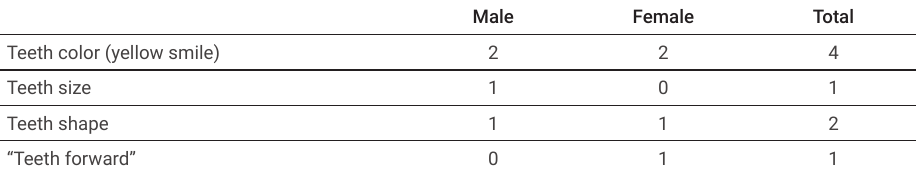
Table 2. Dissatisfaction of 8 teenagers with normal occlusion from March to December 2018 Male Female Total